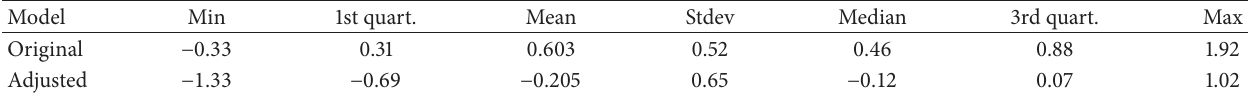
Table 9: A comparison of peak forecast errors 𝑒 𝑚,𝑠 among the original and the adjusted model. The table presents basic statistics computed from 𝑒 𝑚,𝑠 evaluated on testing data.